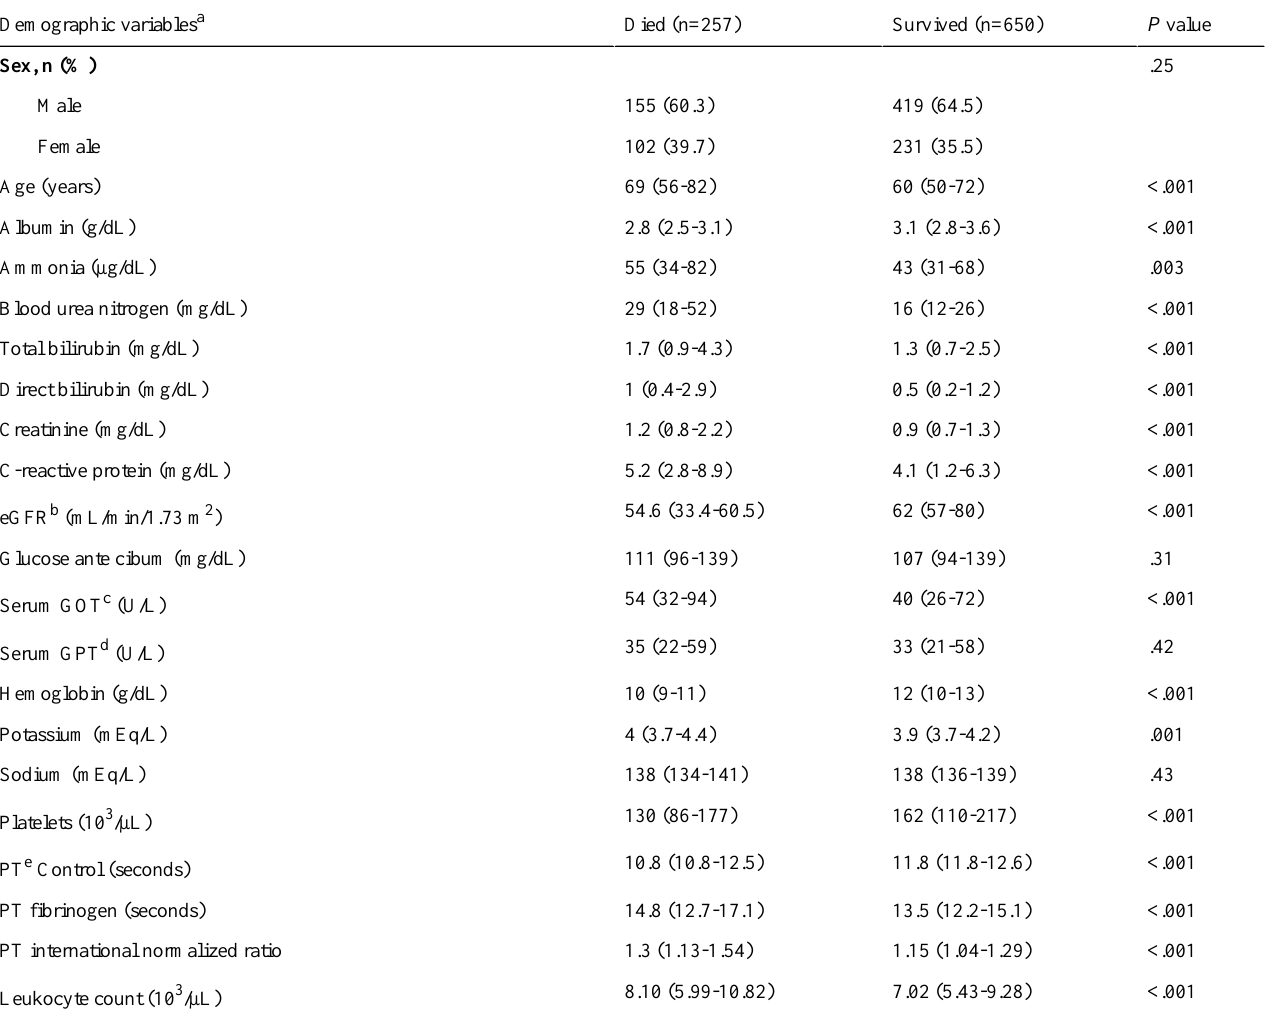
Table 2. Demographic and laboratory characteristics of patients with noncancerous liver diseases according to survival